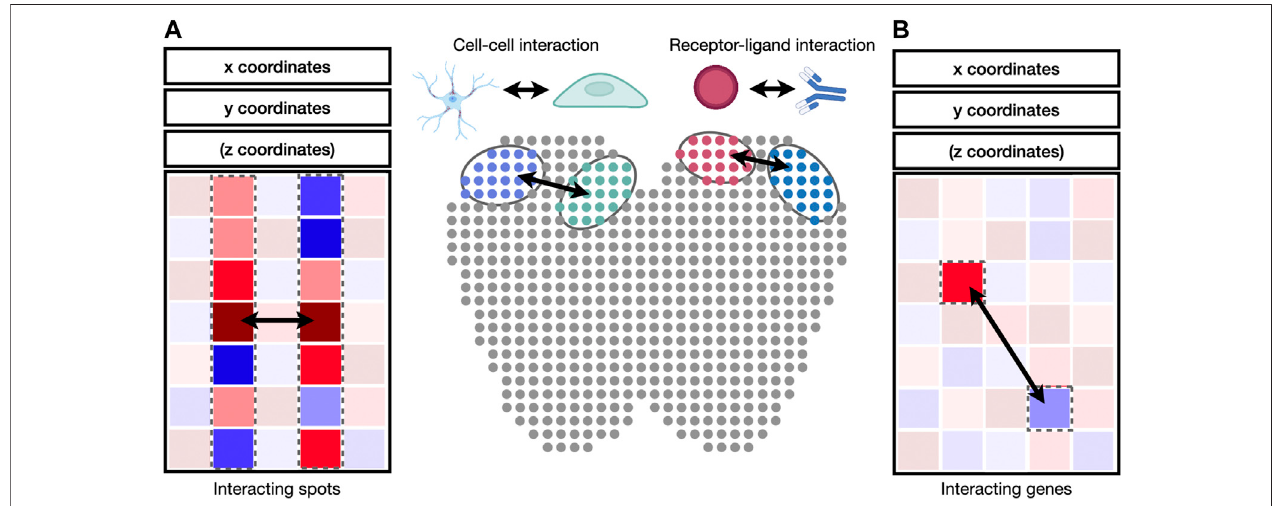
FIGURE 4 | Identi fi cation of cell-cell and receptor-ligand interaction. (A) Cell-to-cell interaction can be identi fi ed by the correlation of gene expression values between cell pairs. (B) Receptor-ligand interaction can be identi fi ed by the correlation between genes in interacting cell